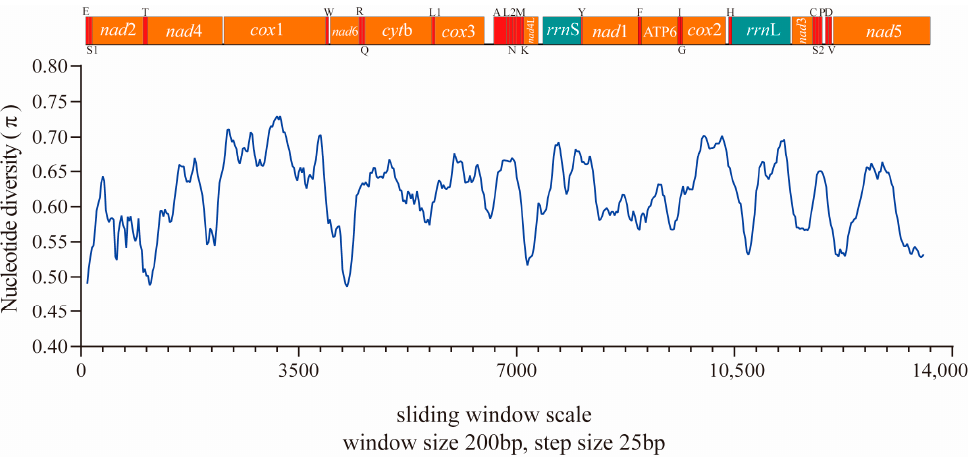
Figure 4. Ratio of the rates of non-synonymous ( dN ) to synonymous ( dS ) nucleotide substitutions ( dN/dS ). ( A ) Bar graph of the pairwise ratios of dN/dS for each of the mitochondrial subunits of the investigated species. ( B ) Box chart illustrating the average pairwise ratios of dN/dS for each of the mitochondrial subunits of the investigated species. The dN/dS ratios are plotted on the y-axis, and the PCGs are plotted on the x-axis.